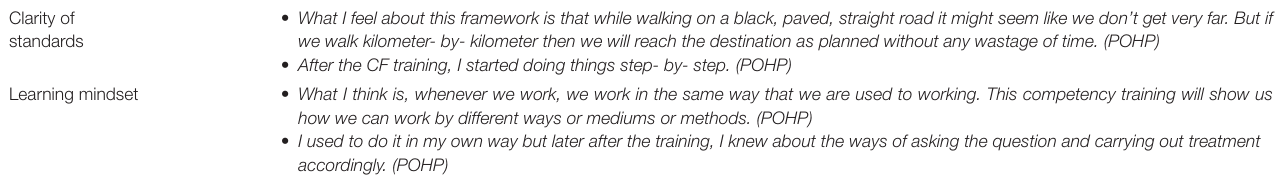
TABLE 1 | What the Competency Framework is to me. Clarity of standards